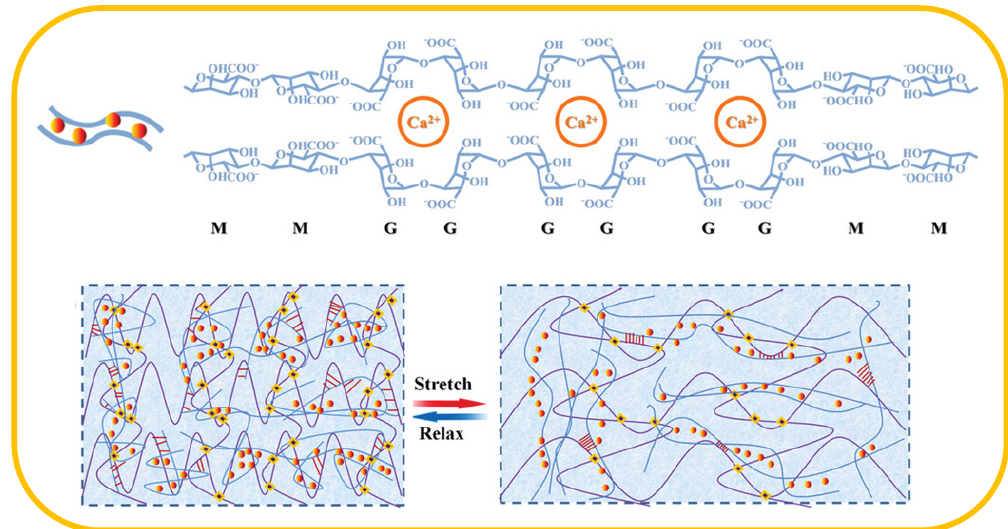
Figure 4. Structure of alginate crosslinked by Ca 2+ and schematic diagram of the variation of the double network in hydrogel under stretching and releasing.